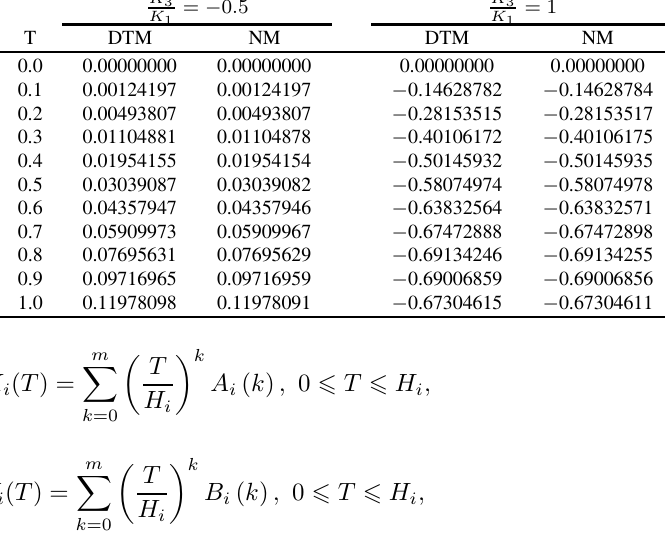
The comparison between the Numerical and DTM solution of X ( T ) for various K 3 K